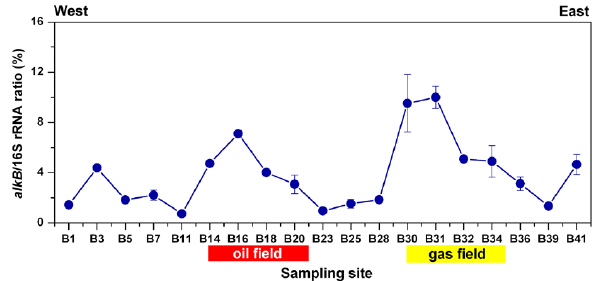
Figure 5. Biogeographical distribution of the percentages of alkB gene copy numbers (representing the number of n-alkane degrading bacteria) in proportion to 16S rRNA gene copy numbers (representing the number of total Eubacteria ) of soil samples collected from east-west direction survey line of Shaozhuang Oil and Gas Field (n=3). Soils were collected at a depth of 60 cm.